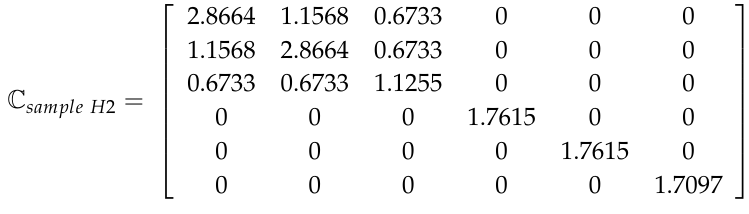
Table 3. Upscaling results of four samples using self-consistent scheme (SCS) method.